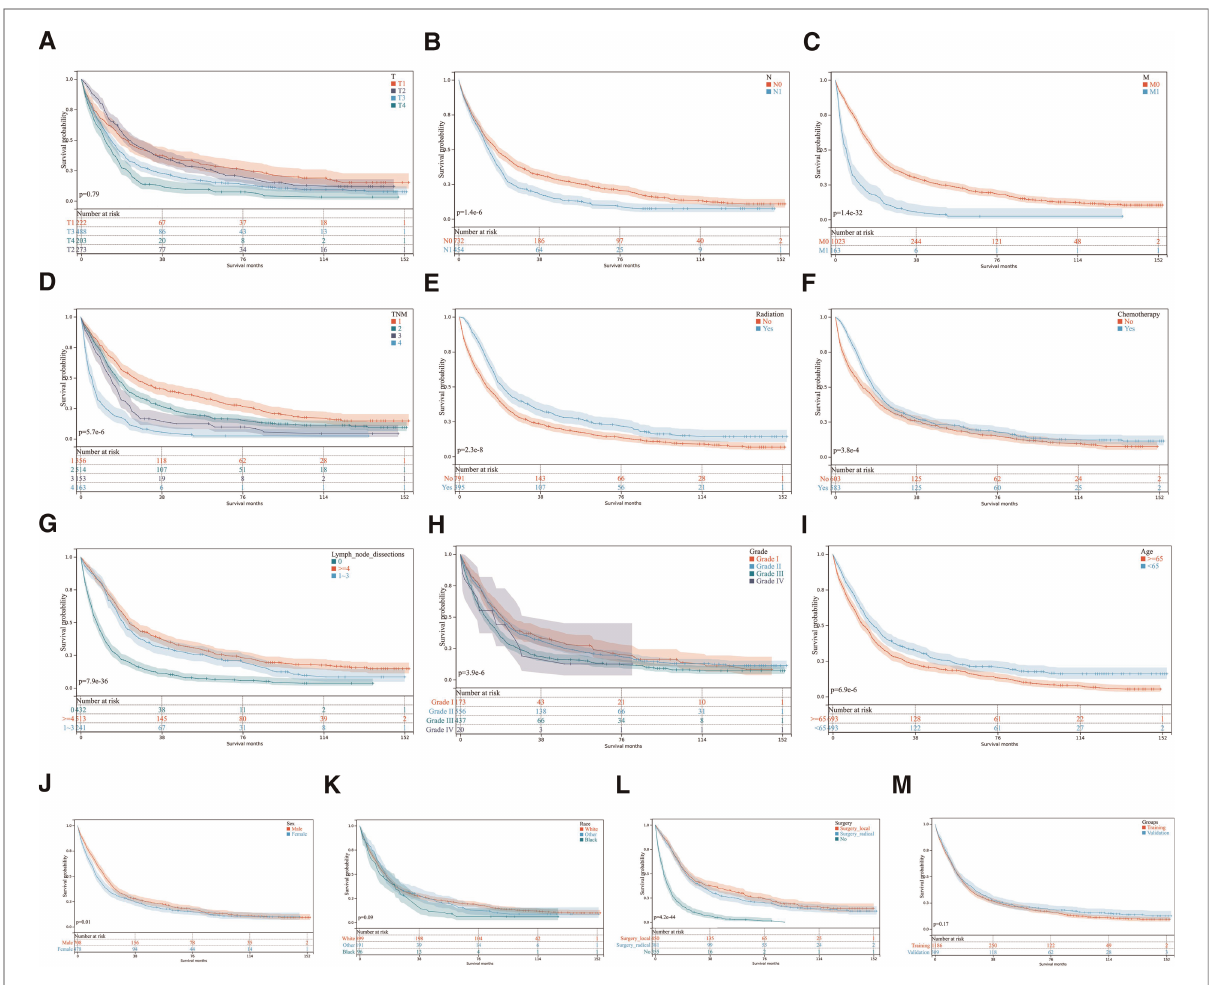
FIGURE 2 Kaplan-Meier curves for OS. ( A – L ) KM curves show univariate analysis of survival based on different clinical variables. ( A ) T, tumor stage; ( B ) N stage, lymph node metastasis stage; ( C ) M stage, distant metastasis stage; ( D ) TNM stage, Tumor-Node-Metastasis stage ( E ) Radiotherapy; ( F ) Chemotherapy; ( G ) Lymph node dissection; ( H ) Tumor differentiation grade; ( I ) Age; ( J ) Sex; ( K ) Race; ( L ) Surgery method. ( M ) Kaplan-Meier survival analysis in training and validation